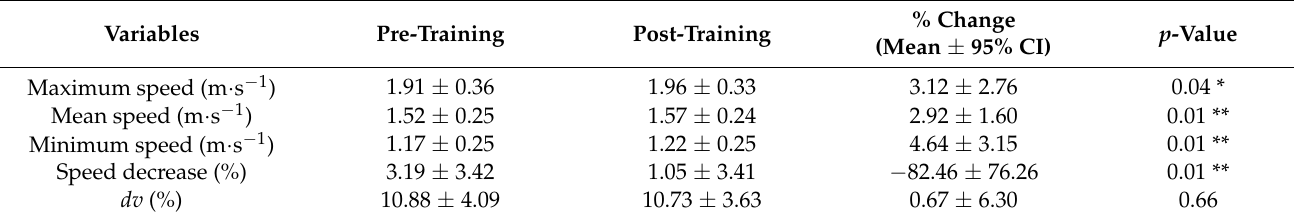
Table 1. Performance-related variables values assessed during the maximal 25 m front crawl pre- and post-training period of four